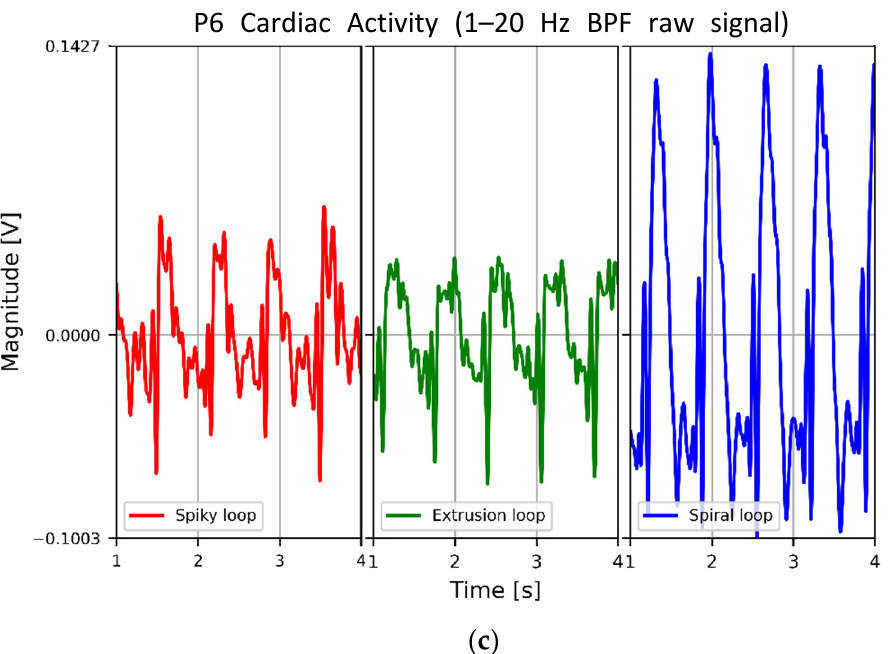
Figure 6. Differences in the acquired signals according to the shape of the fabric loop sensor for each measurement position: ( a ) P2, ( b ) P4, and ( c ) P6 (spiral > spiky > extrusion).